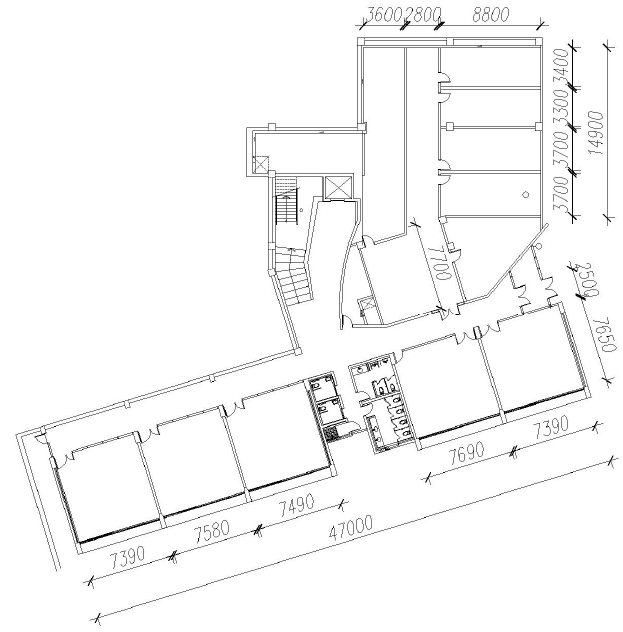
Figure 1. Floor plan of the target building (reference floor).